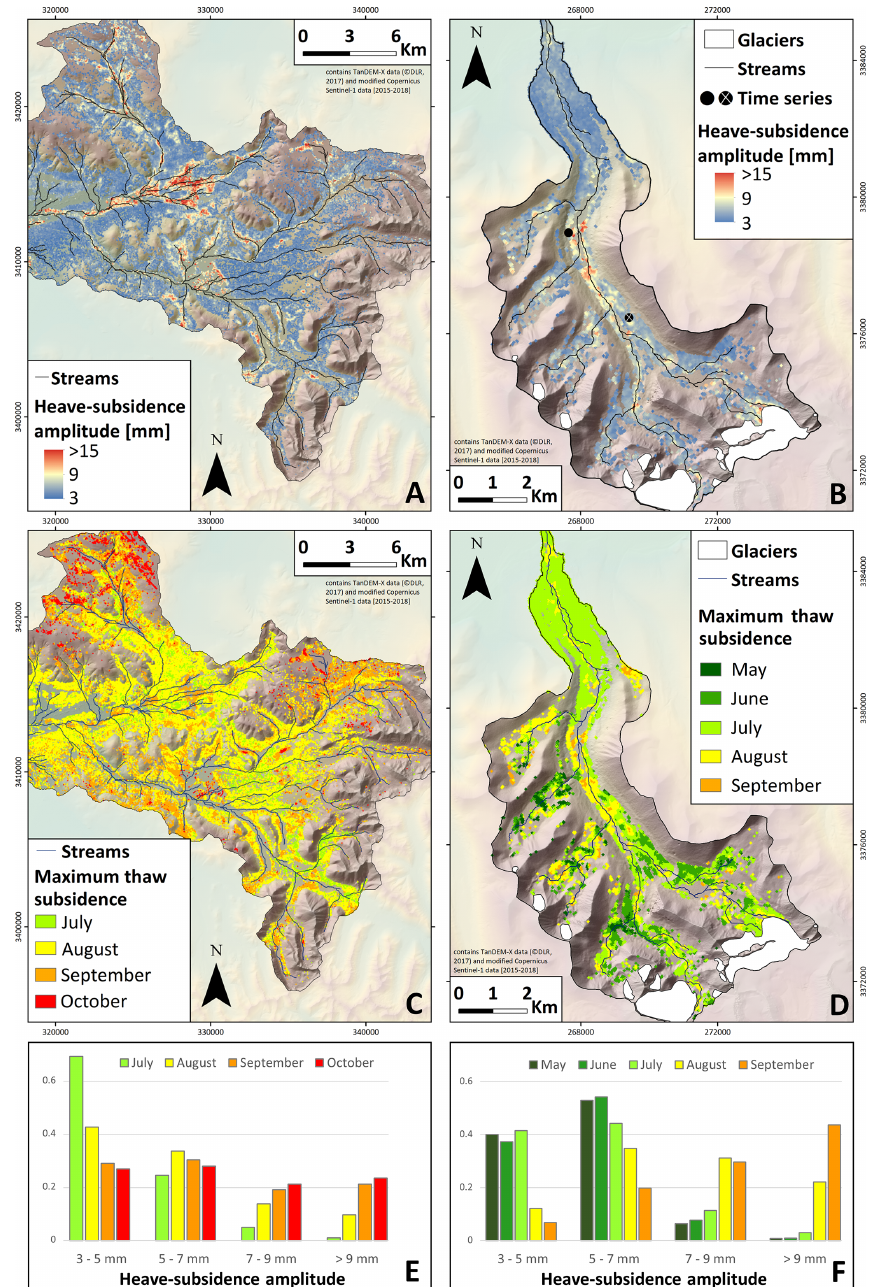
Figure 5. Parameters of the HSM (modified Copernicus Sentinel-1 data, 2015–2018) over TanDEM-X DEM (©DLR, 2017). Spatial vari- ations in the mean amplitude (a, b) and the day of maximum subsidence (c, d) of the HSM within the Niyaqu and Qugaqie basins. The locations of the time series of Fig. 6a are displayed as black dots. (e, f) Normalized distribution of the months in which the heave–subsidence cycle reaches its maximum subsidence split up into four groups according to their amplitude for the Niyaqu and Qugaqie